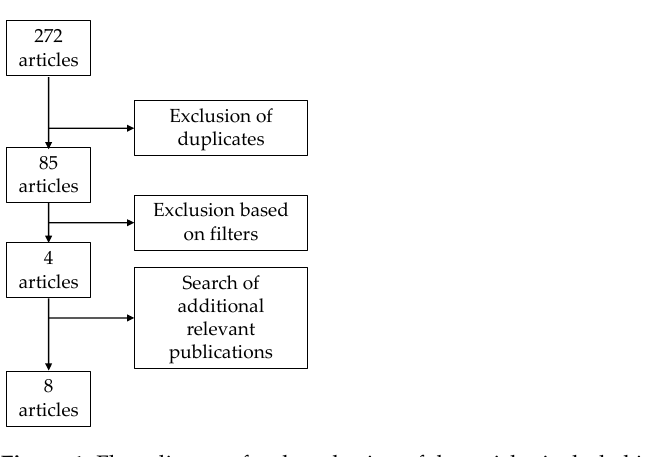
Figure 1. Flow diagram for the selection of the articles included in this review.